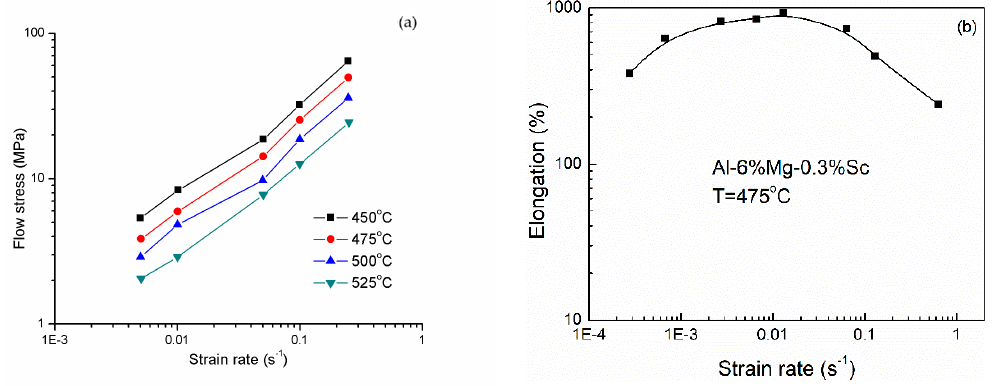
Figure 4. ( a ) Flow stress as a function of strain rate, reproduced from [78], with permission from Elsevier, 2016; ( b ) Elongation as a function of strain rate reproduced from [70], with permission from Elsevier, 1998.